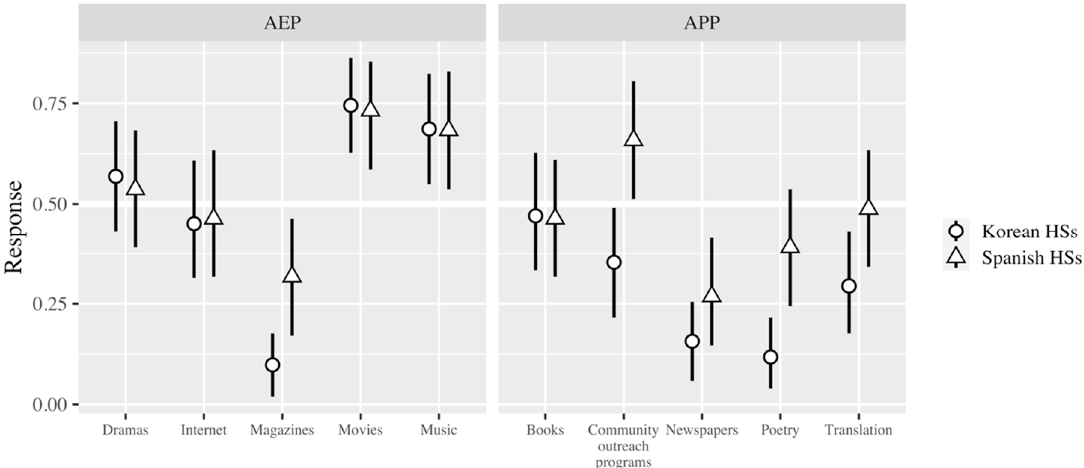
Figure 1. Activities and materials considered beneficial by HSs across HL groups. Table 5. Activities and materials considered beneficial by HSs across HL groups.